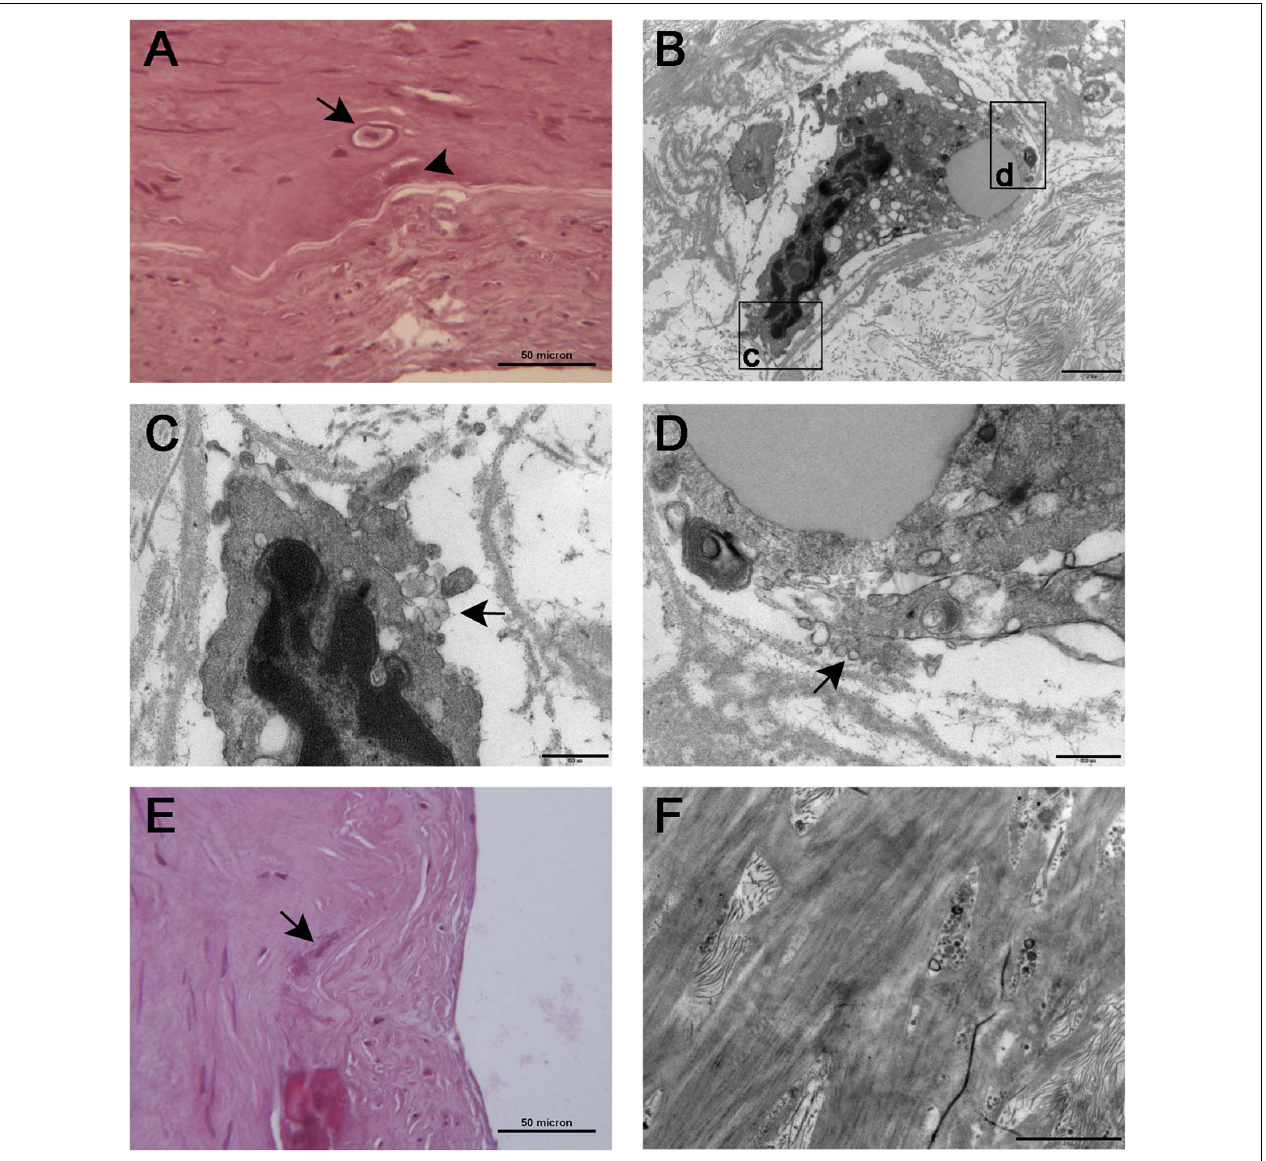
FIGURE 6 | Histological (A) and TEM (B) appearance of osteoblast-like cells [arrow in (A) ] seen in proximity of the inner elastic lamina. The cells were embedded in an empty lacuna that ultrastructural examination showed to be rich in particulate and filamentous proteoglycans. The boxed areas are seen at higher magnification in (C,D) , respectively; cell membrane ruffling with extrusions and matrix vesicles budding from the cell surface (arrows) can be appreciated in both images. (E) At histology, large aggregates of calcified vesicles were seen as extracellular deposition of amorphous, basophilic substance [arrow in (E) , also seen in (A) , arrowhead] close to the inner elastic lamina. (F) TEM showed clusters of calcified matrix vesicles permeating the fenestrations of the inner elastic lamina. Scale bars = 50 µ m (A,E) , 2 µ m (B,F) , and 0.5 µ m (C,D)